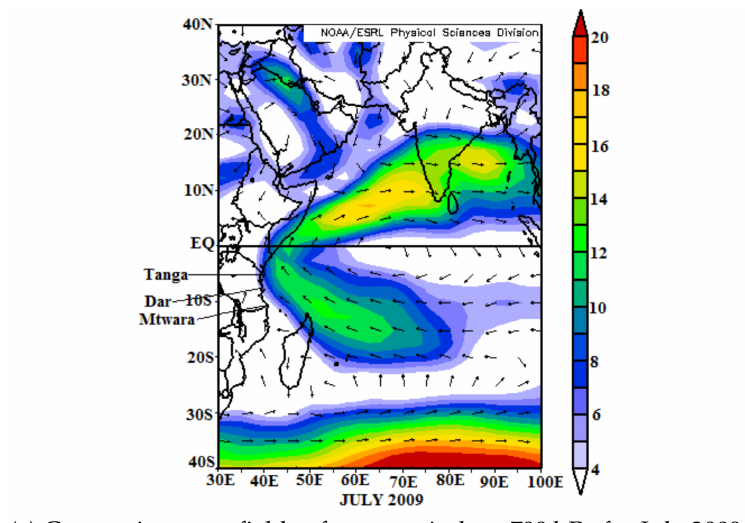
Figure 5. July horizontal wind vector for 1961, 1982, and 2009, representing the anomalously wet July ( a ), the second wettest ( b ) and one of the driest July ( c ) months,